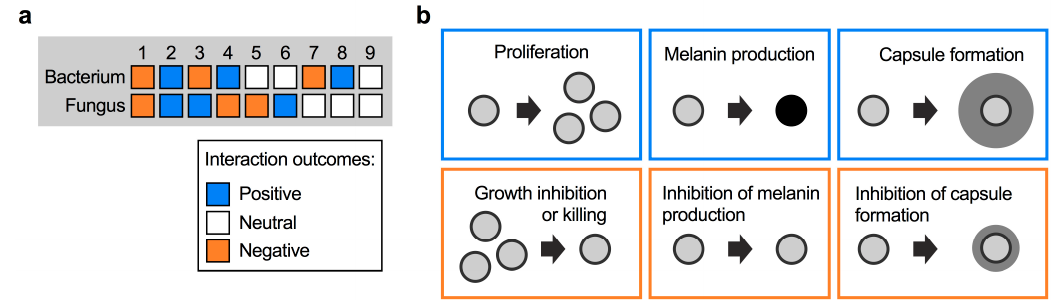
Figure 1. Types of fungal–bacterial interactions. ( a ) Possible types of interactions between fungi and bacteria, and their respective outcomes. ( b ) Examples of positive and negative interaction outcomes for C. neoformans cells following exposure to bacteria. Bacteria may induce fungal proliferation, or kill fungal cells. Bacteria may also trigger the expression of fungal virulence factors (e.g., formation of melanin pigment or polysaccharide capsule), or repress formation of these factors. The different outcomes are color-coded depending on their impact on the fungus, i.e., outcomes likely to be beneficial to the fungus are boxed in blue, while outcomes likely to be unfavorable are boxed in orange.